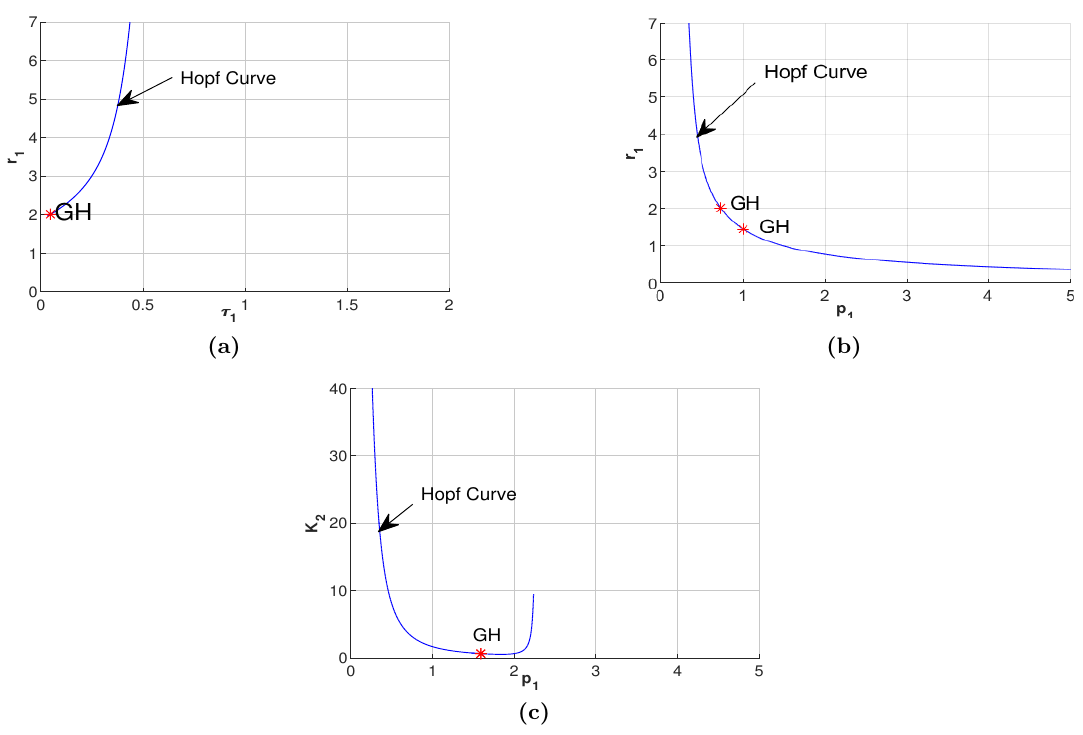
r 1 . (b) The two parameters − p K 1 − 2 .